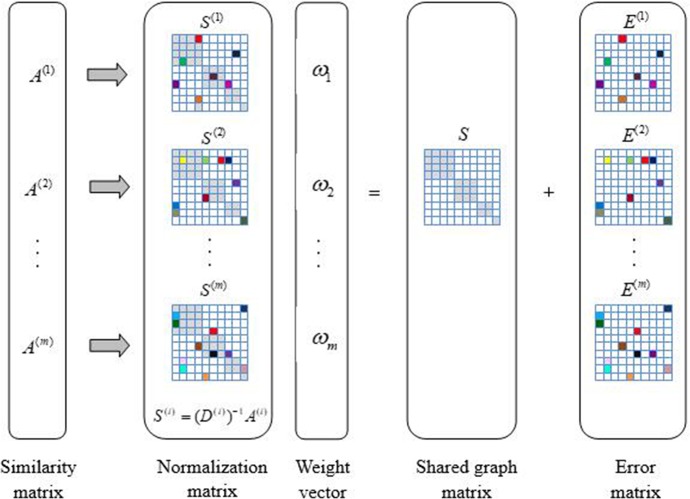
Overview of the shared graph matrix construction.